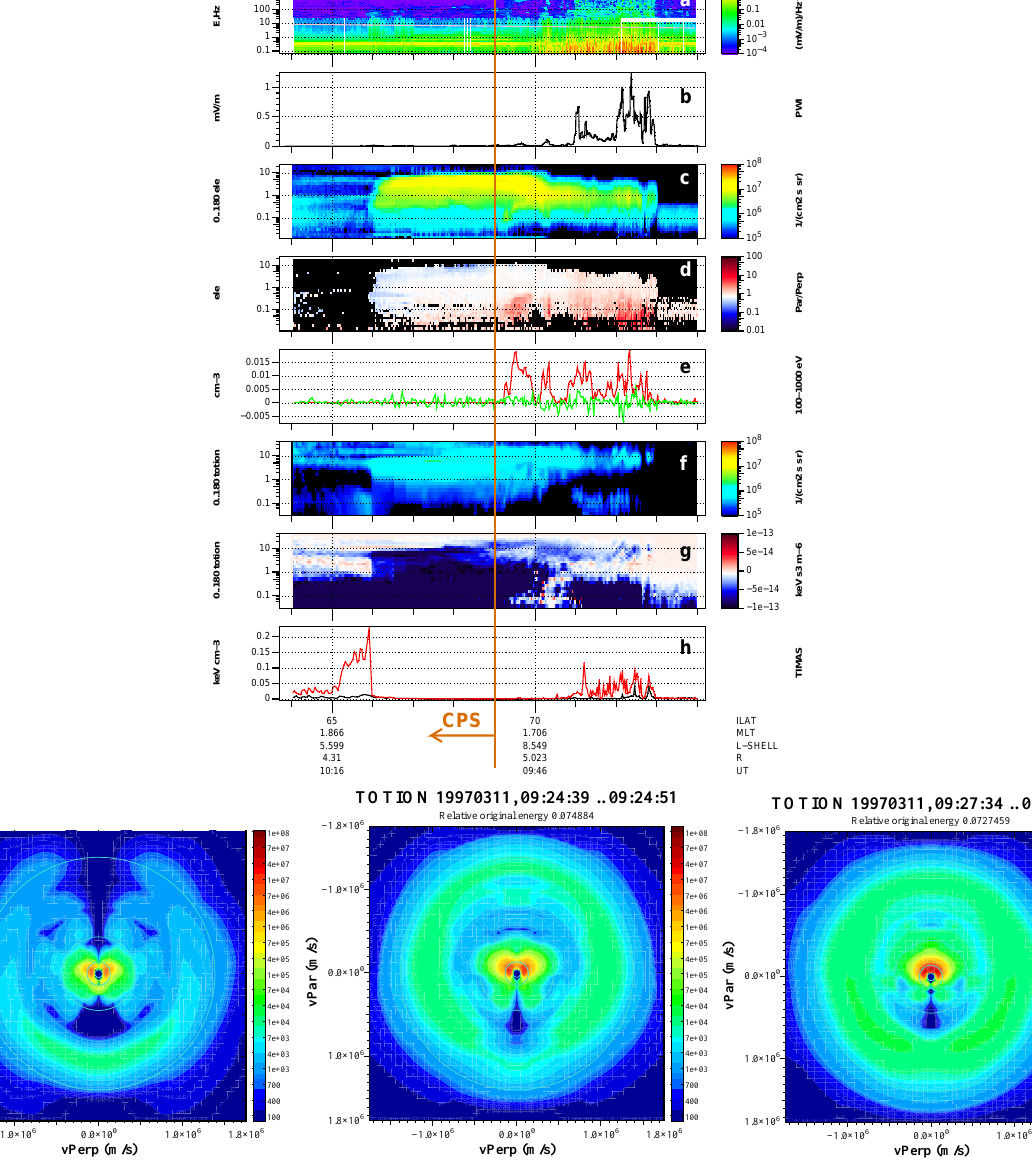
Fig. 4. Polar data for event 11 March 1997. Format is similar to Fig. 3. The estimated CPS/BPS boundary is also shown. On the bottom of the main plot, three example distribution functions corresponding to shell distributions are shown as